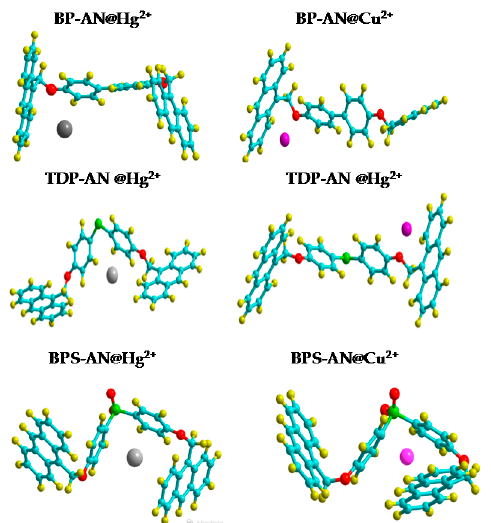
Figure 2. O ptimized Hg 2+ -anthracene and Cu 2+ anthracene complexes. S, green; O, red; C, blue; H, yellow; Cu, violet; Hg, dark gray sphere.